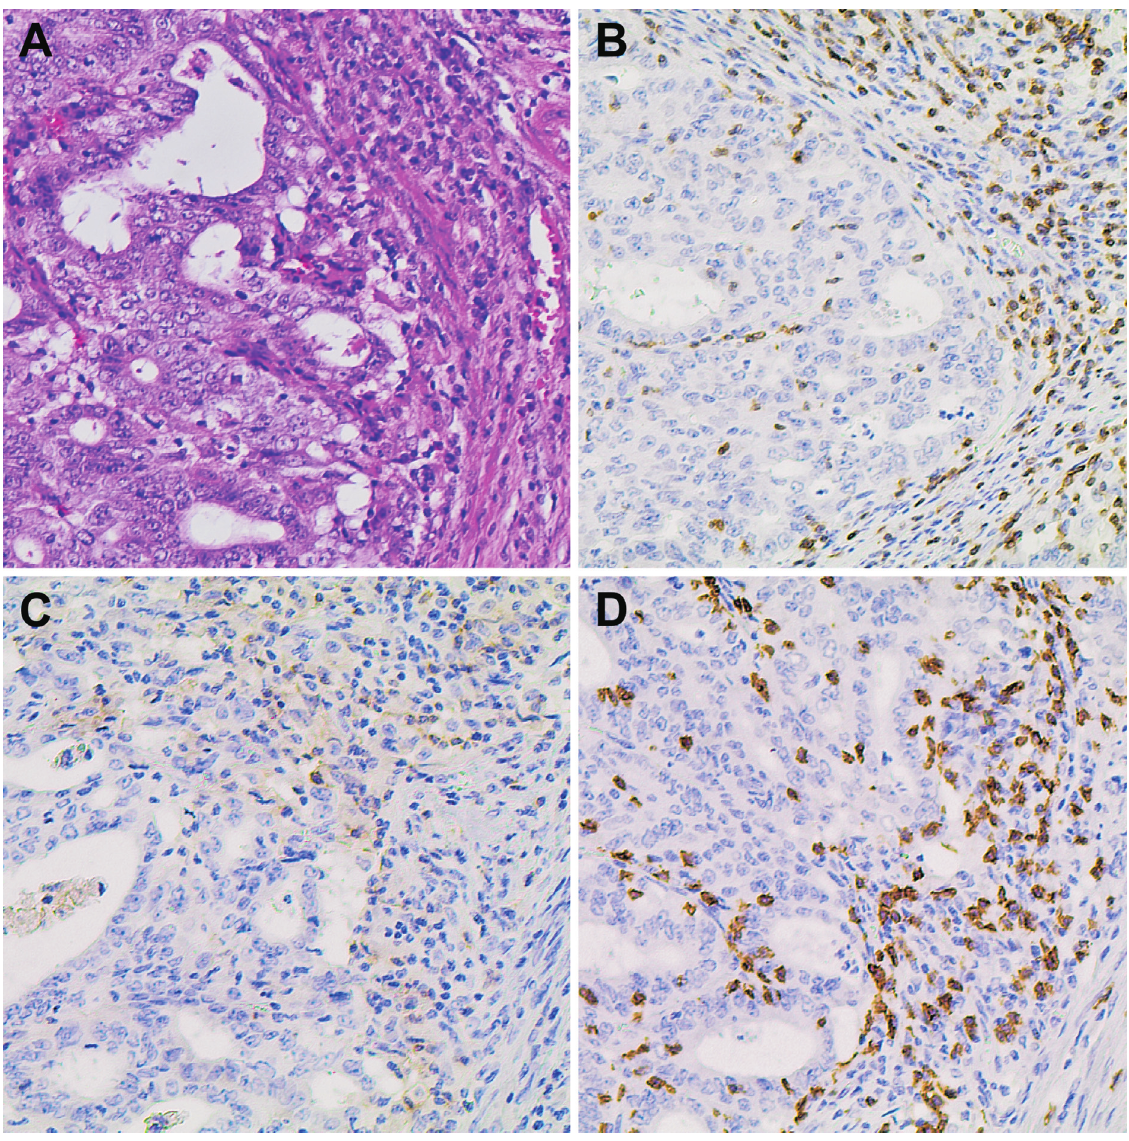
Figure 3 - Immunohistochemical staining for T lymphocyte markers on the peri and intra-tumoral areas of the EC (original magnification x200) . (A) H&E (hematoxilin-eosin). Brown nuclear staining is indicative of positive expression (B) CD3, (C) CD4 and (D) CD8